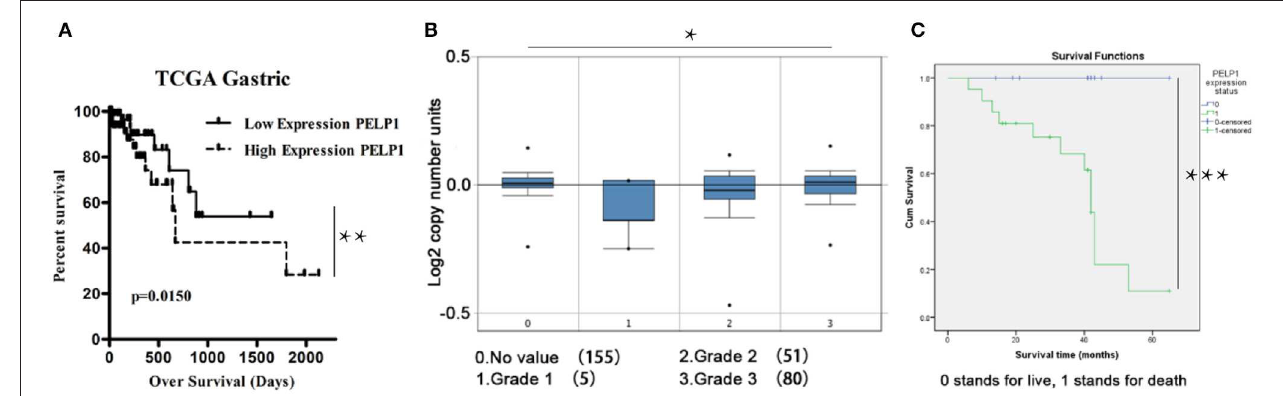
FIGURE 5 | Low PELP1 protein expression is a significant prognostic factor favoring good survival in gastric cancer (GC) patients. GC patients were grouped in 2 categories, those having high and low PELP1 gene expression based on the median. Box plots and data derived from ONCOMINE. Bioinformatics result was partly demonstrated by Kanplan-Meier survival analysis. (A) The survival curve analysis showed that there is a obviouly increase in the survival of the patients that have low PELP1 expression. (B) Box plots of gastric cancer grade showed that expression of PELP1 is relatively increased in higher grade. Values are the mean ± SEM. (C) The data from thirty-six GC tissues microarray revealed that patients with decreased PELP1 showed a longer OS ( p < 0.05) (* p < 0.05, ** p < 0.01, *** p <